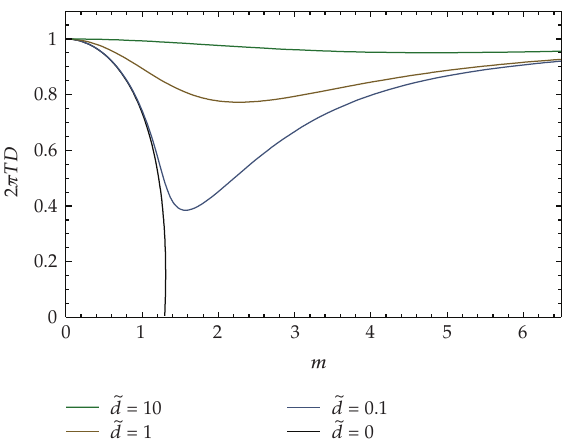
Figure 16: Approximate baryon di ff usion coe ffi cient D as a function of the quark mass to temperature ratio (cid:11) m . The curve for d (cid:5) 0 reproduces the result from (cid:8) 45 (cid:9) . The exact results derived in (cid:8) 117 (cid:9) show deviations most notably in the limit of large m